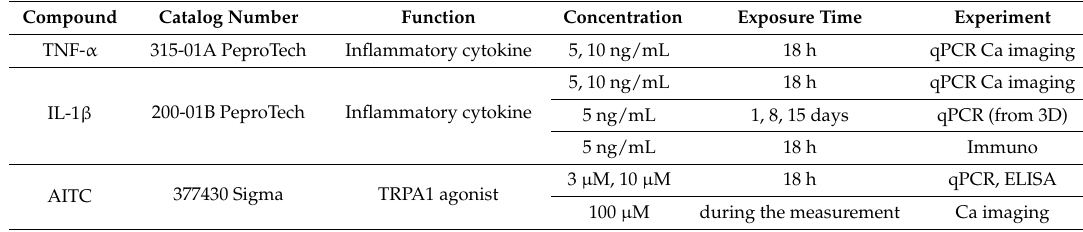
Table 5. Details of cell culture